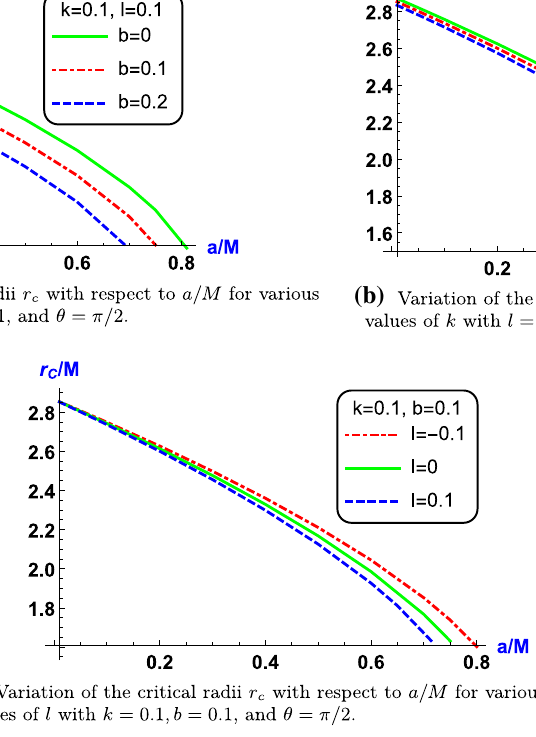
Fig. 2 Plots of critical radius for various